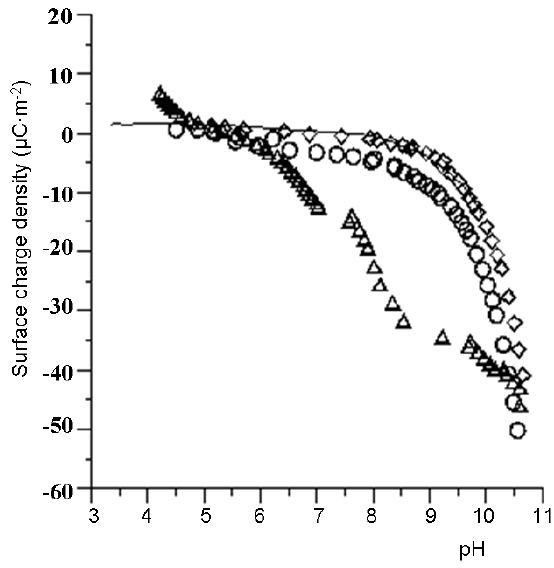
Figure 6. The surface charge of TiO function of pH in the presence of Zn(II) ions. Zn